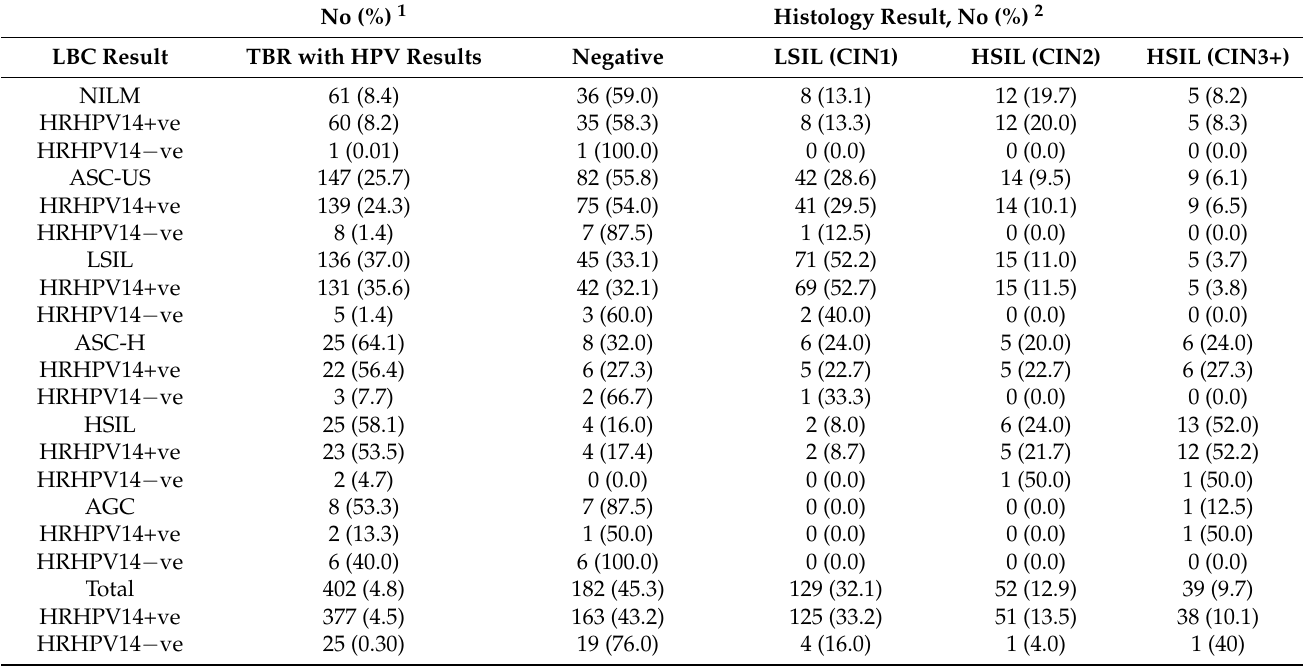
Table 8. The histologic correlation for LBC and HRHPV14 results